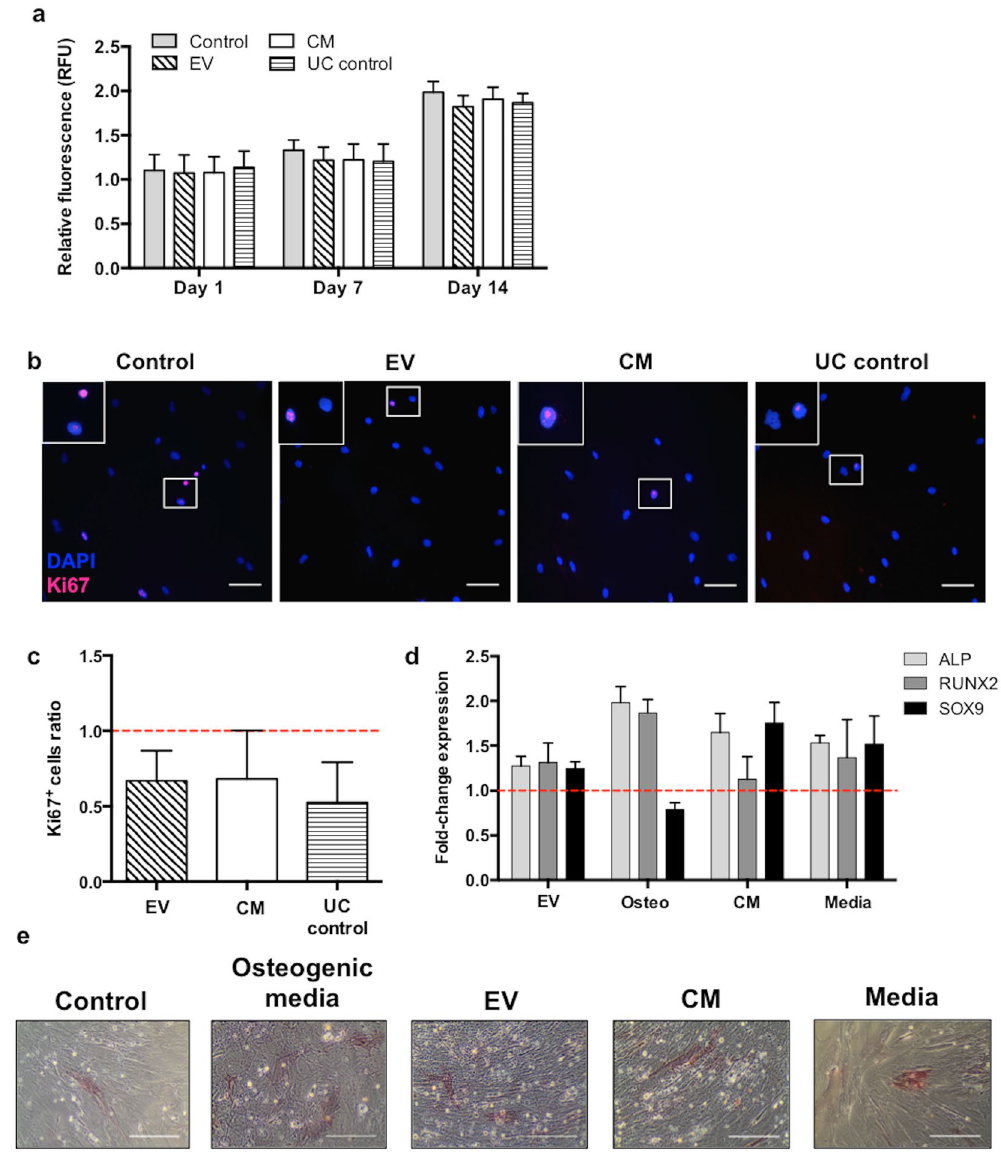
Figure 3. Stimulation of MSC with DC-derived EV is not cytotoxic and do not affect significantly their proliferation nor differentiation capacity. ( a ) MSC were incubated alone, with DC-derived EV (10 μ g of protein), total conditioned media or 100 K ultracentrifugation supernatant (UC control) for 14 days. At days 1, 7 and 14, MSC were incubated with resazurin and conversion to resorufin was determined by fluorescence measurement (RFU = relative fluorescence units). Relative fluorescence at each timepoint normalized to day 0 is depicted. ( b ) MSC were incubated alone (Control), with 50 μ g protein from EV, total conditioned media (CM), or 100 K ultracentrifugation supernatant (UC control) for 24 h, before staining for the Ki67(- AlexaFluor 647; pink) proliferation marker and DAPI for nuclei (blue). Scale bar: 100 μ m. ( b ) Stained cells were imaged by fluorescence microscopy in 20 random fields, the total number and the number of Ki67 + cells were counted, and are represented as a ratio to non-stimulated control condition (dashed line) (n = 4 different DC donors). All bar graphs represent average ± SD. n = 3 different DC donors. ( d ) Fold-change gene expression by RT-qPCR (average ± SD) of osteogenic markers (ALP and RUNX2) and a chondrogenic marker (SOX9) of MSC stimulated with DC-derived EV, osteogenic media (osteo: supplemented with Dexamethasone 10 − 7 M, β -glycerophosphate 10 − 2 M and ascorbic acid 5 × 10 − 5 M), conditioned media (CM), or protein extracted from complete media (including cytokines) that was not in contact with cells (media), comparatively to MSC in basal conditions (dashed line; n = 2 different DC donors). ( e ) ALP activity staining (pink/red), associated with early osteogenic differentiation, of MSC cultured in the presence of the indicated stimuli for 14 days. Although ALP activity staining is similar in stimulated conditions, only osteogenic media lead to morphological changes of MSC characteristic their osteogenic commitment. Scale bar: 1